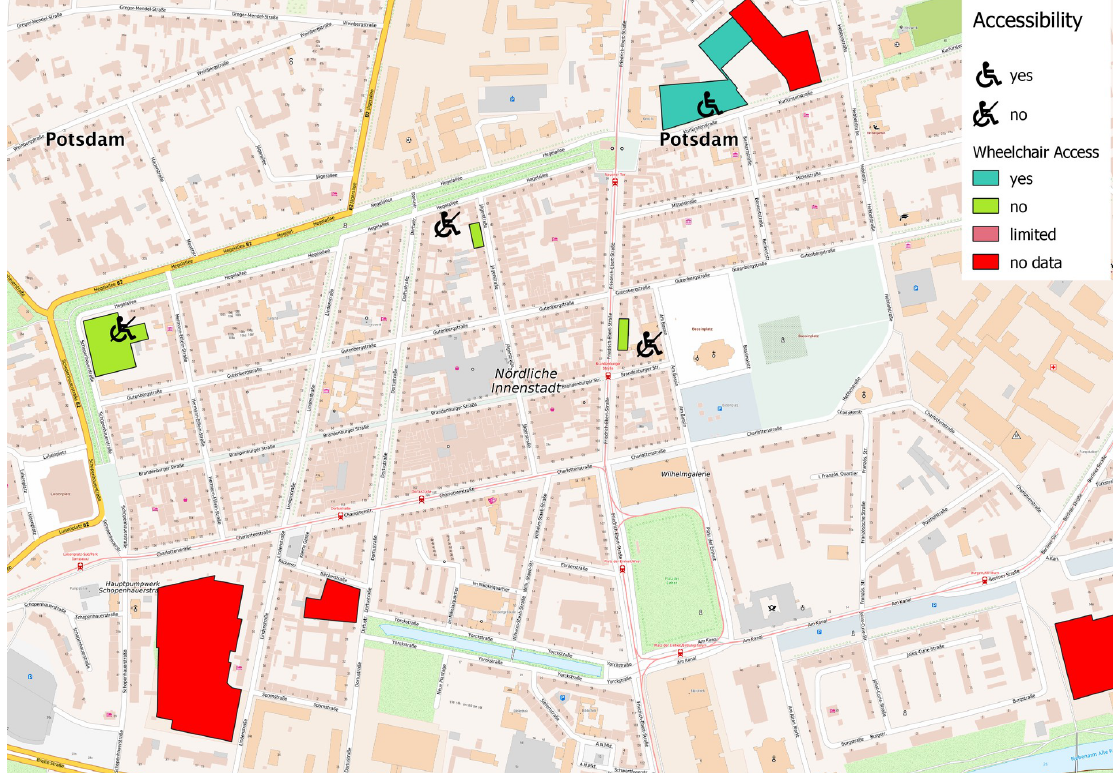
Figure 2. School Accessibility Map: A thematic map representing wheelchair access to school buildings in Potsdam, Germany. The wheelchair access may be provided, not provided, limited or there may be no data given. Only one attribute is needed to generate the thematic map as shown